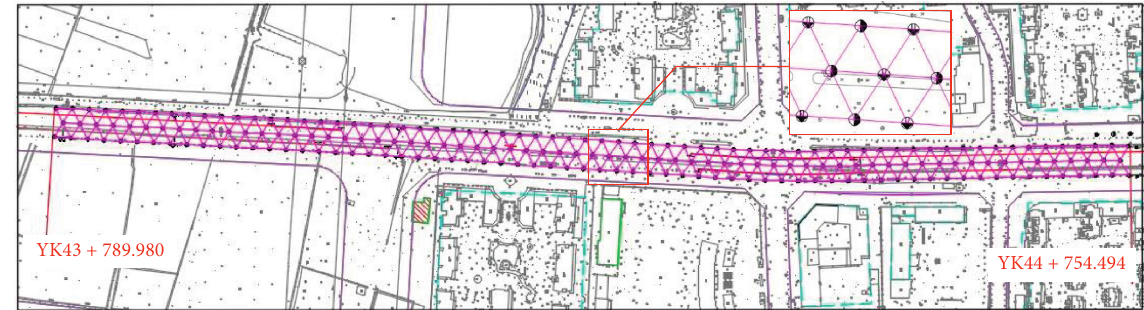
Figure 2: Layout sketch of the prospecting boreholes and survey